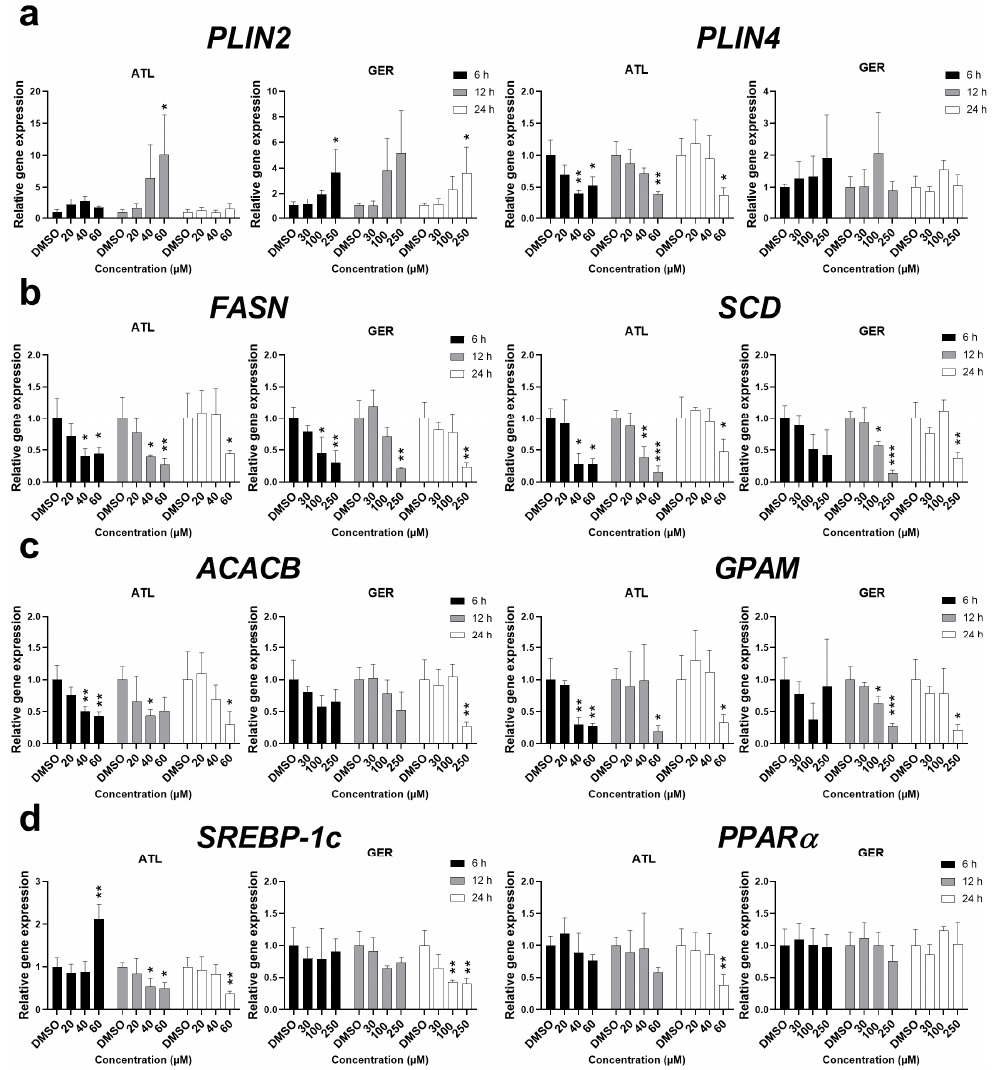
Figure 6. Relative gene expression changes in major genes related to ( a ) lipid sequestration, ( b ) de novo lipogenesis ( c ) triacylglyceride synthesis and ( d ) lipid metabolism regulation transcription factors, after a single exposure of ATL and GER to differentiated HepaRG cells. The relative mRNA changes were measured after 6, 12, and 24 h, using RT-qPCR. Results are expressed as the mean ± SD from three independent experiments. Results statistically significant: p < 0.05 (*), p < 0.01 (**), p < 0.001 (***).